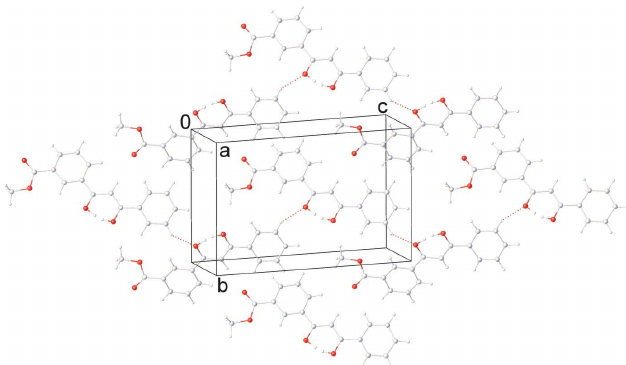
Figure 3 Intermolecular C—H (cid:2)(cid:2)(cid:2) O hydrogen bonding in the crystal structure of 3-